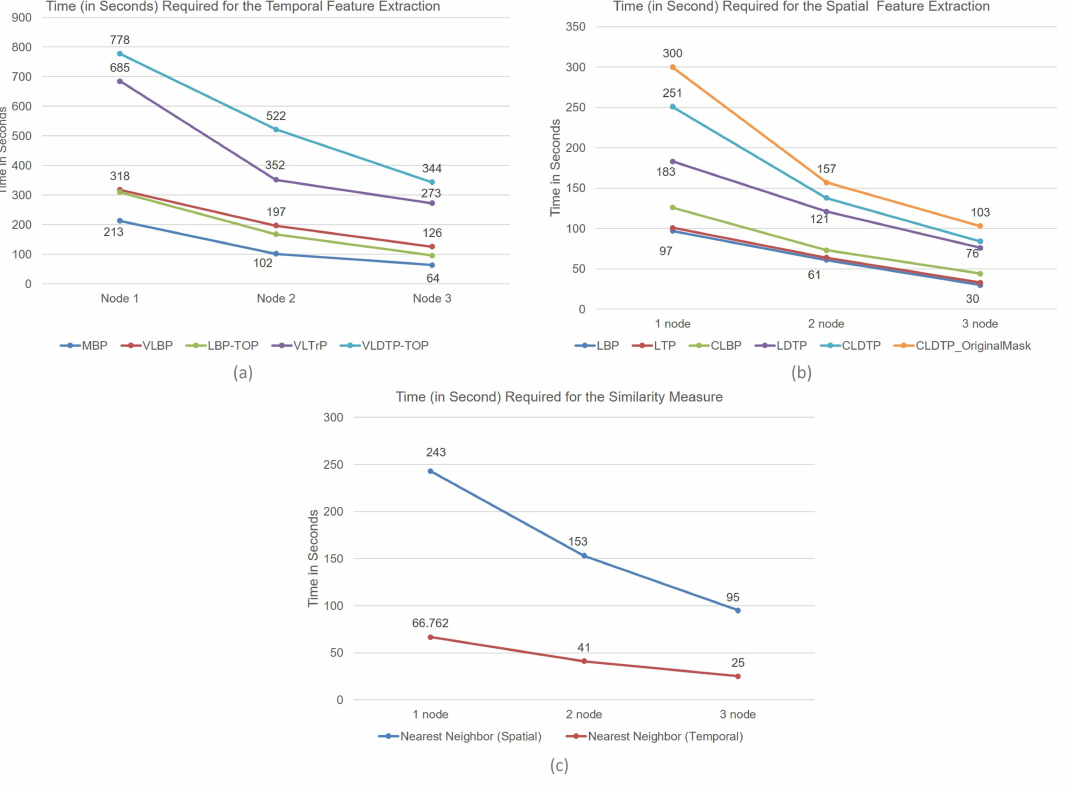
Figure 11. Scalability of the low-level APIs for distributed video annotation on the STAD dataset. ( a ) Time (in seconds) required for the dynamic feature extraction and ( b ) time (in seconds) required for the spatial feature extraction. ( c ) time (in seconds) required for the similarity measure